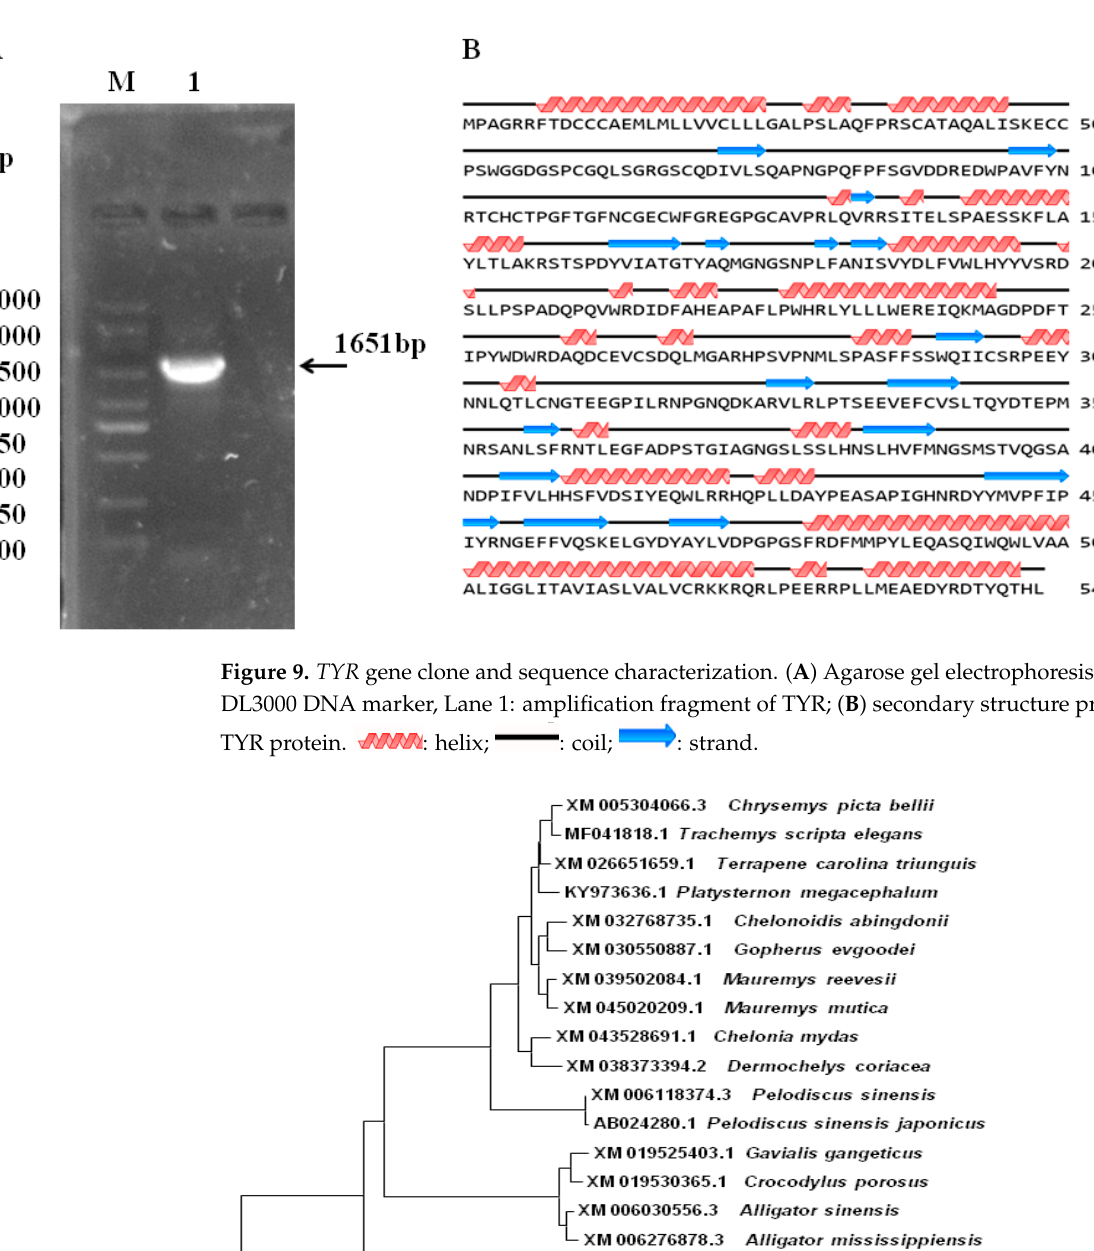
13 of 19 According to phenotypic differences, the five skin colors can be divided into three groups: wild phenotype (GY), intermediate phenotype (YB, BY and BSY) and albino phenotype (YL). The TYR gene sequences from each group individuals were aligned and analyzed.